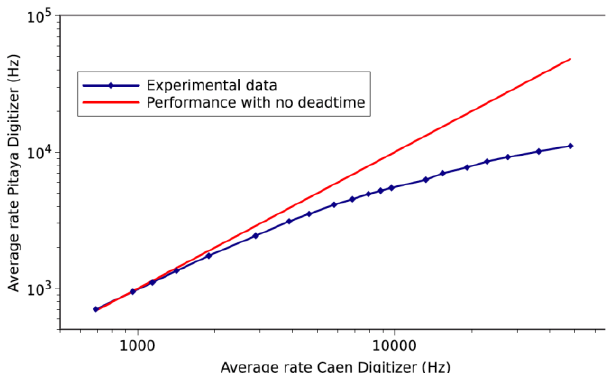
Figure 1: Performance of the RedPitaya digitizer as a function of the counting rate. The average rate of the Red Pitaya digitizer respect to the CAEN digitizers is presented as a function of the counting rate.